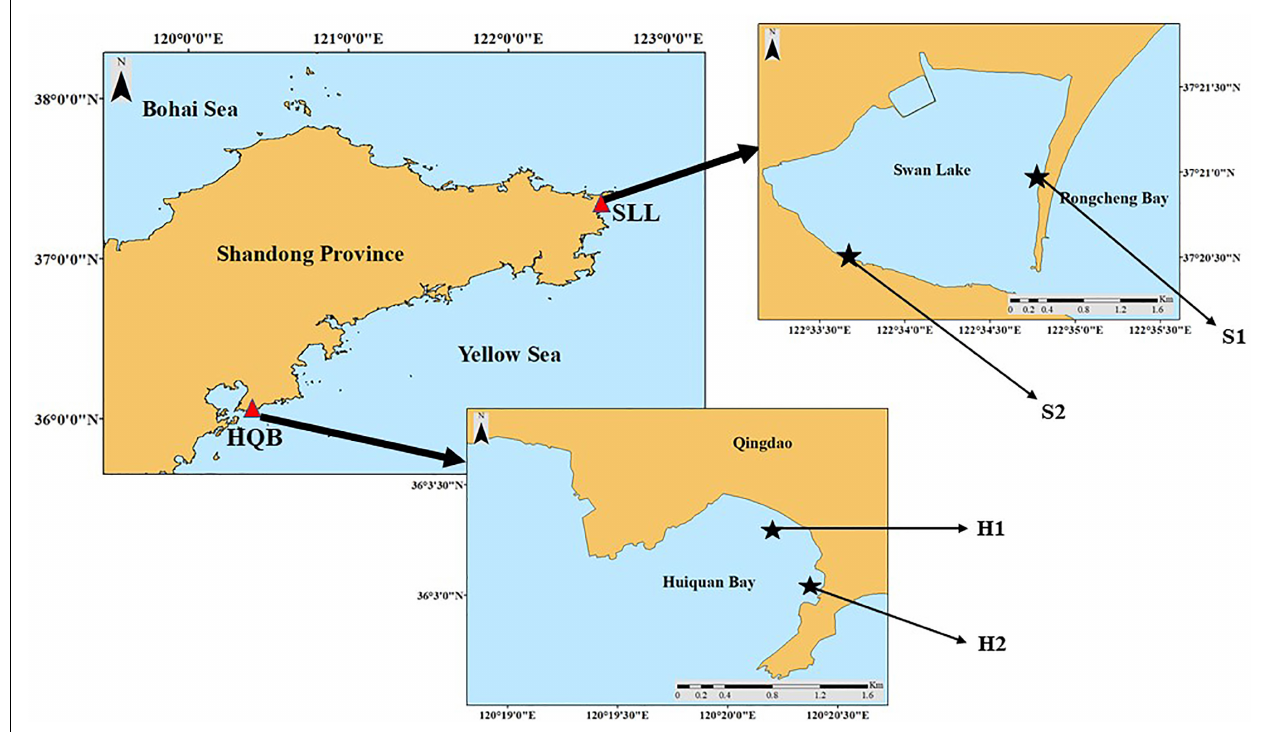
FIGURE 1 | Zostera japonica study sites in Swan Lake (SLL) and Huiquan Bay